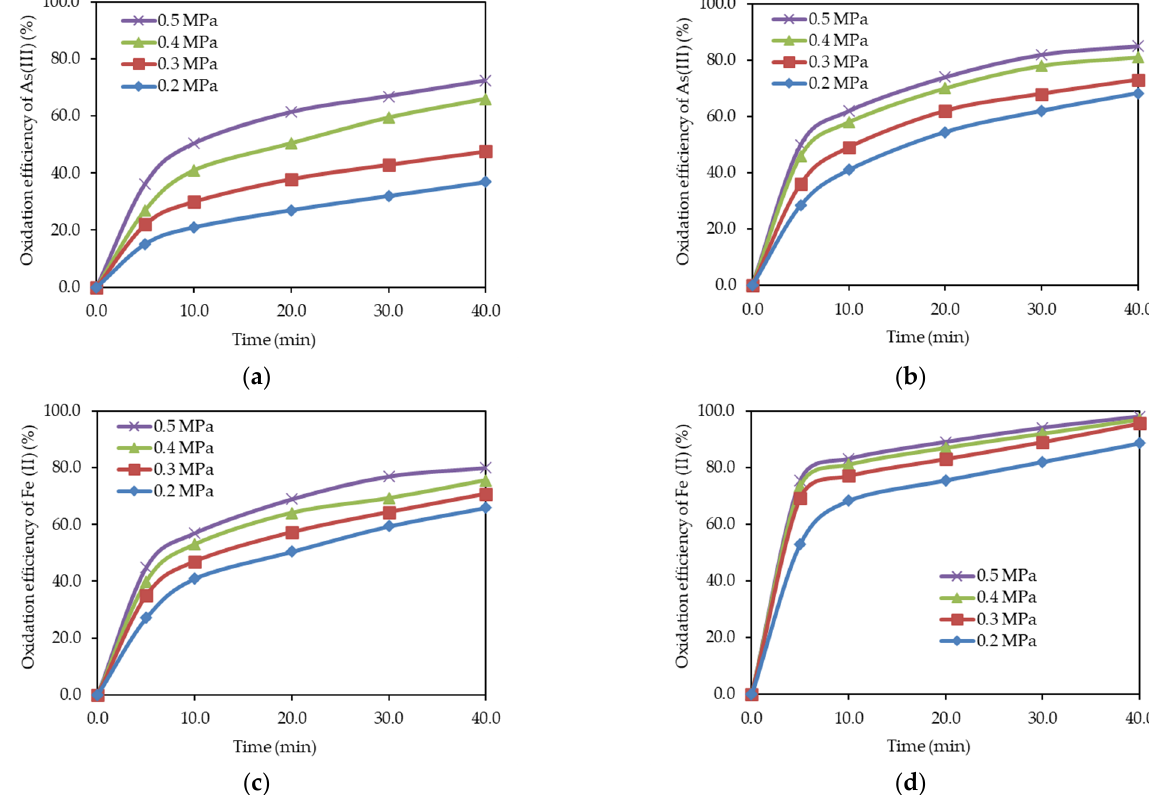
Figure 6. As (III) and Fe (II) oxidation efficiency as a function of temperature with ( a , c ) and without ( b , d ) Cu (II) ions.